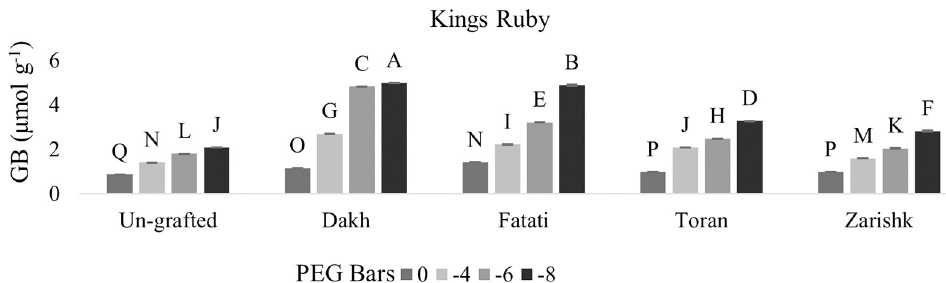
Fig 7. Glycine betaine content (GB) of un-grafted and grafted Kings Ruby scion variety on different wild grapevines under drought stress condition. Data is represented as mean SD and letters showed significant difference at p < 0.05.